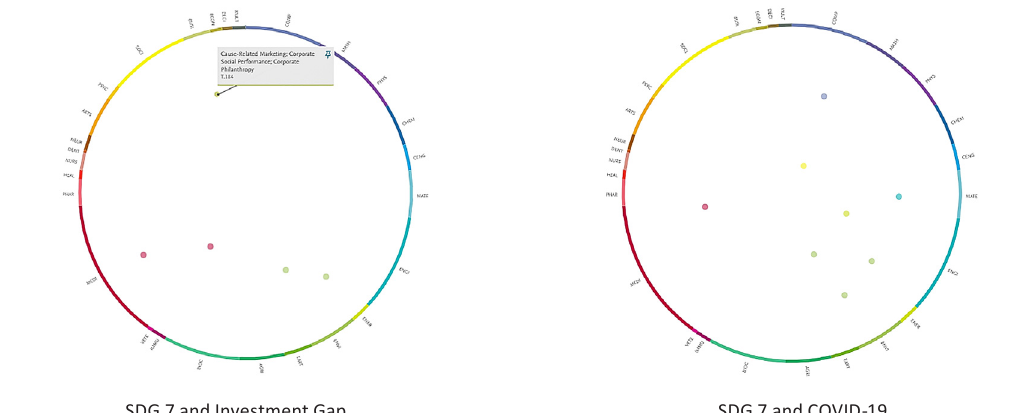
Figure D2. Top 1% topics research area SDG 7 and Investment Gap, SDG 7